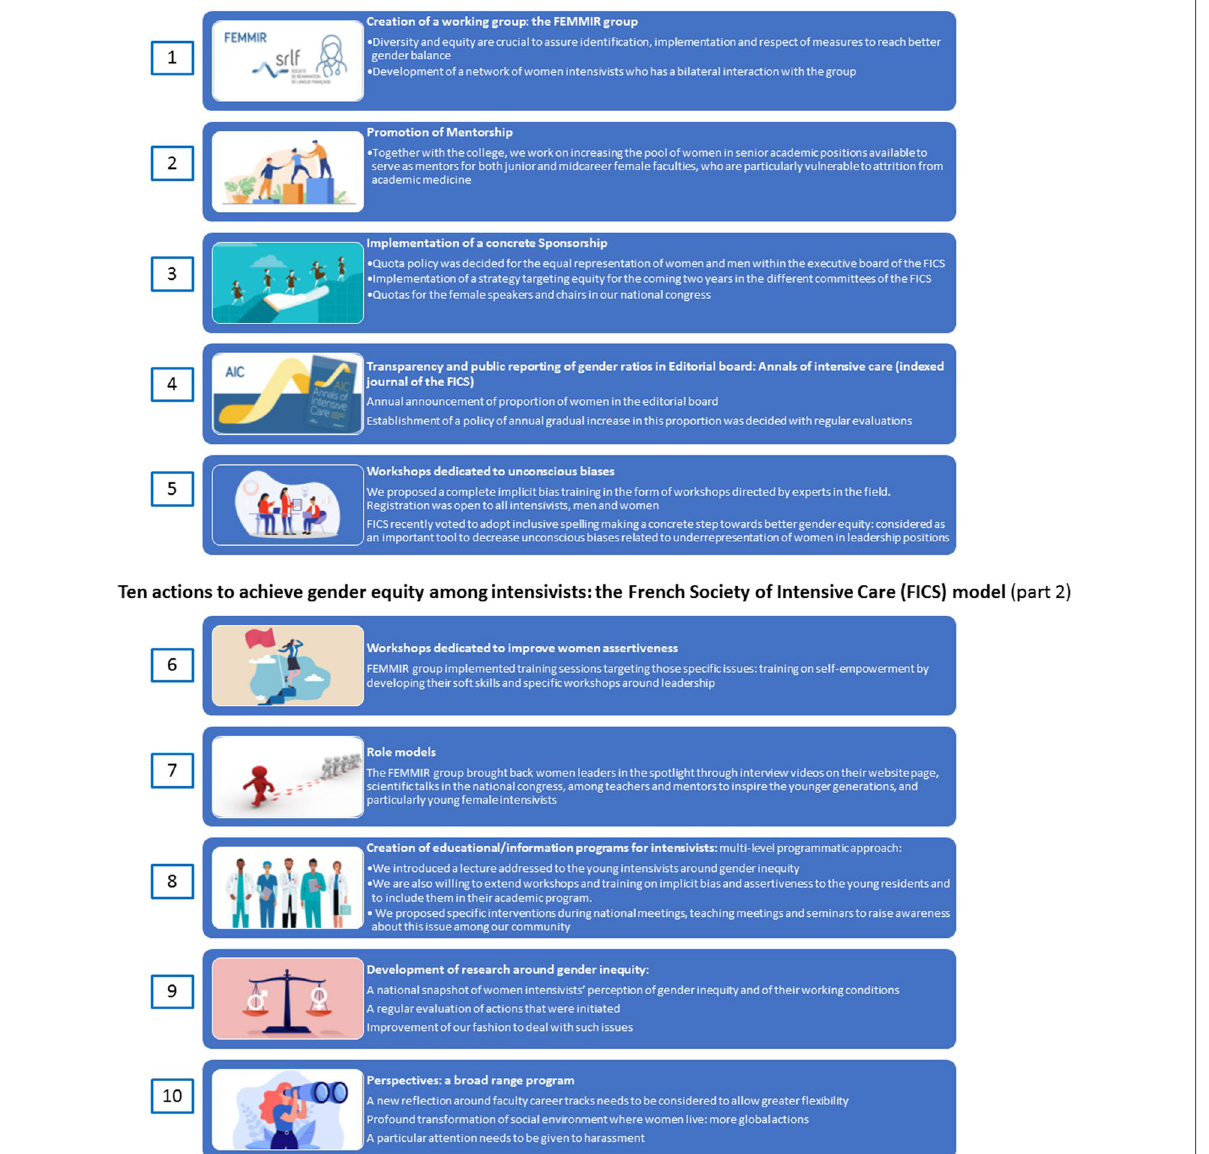
Fig.1 Ten actions to achieve gender equity among intensivists: the French Society of Intensive Care (FICS) model is the summary of the actions carried out by the FEMMIR group (Femmes Médecins en Médecine Intensive réanimation) during 2 years following o its creation. Part 1: represents actions 1 to 5, and Part 2 represents actions 6 to